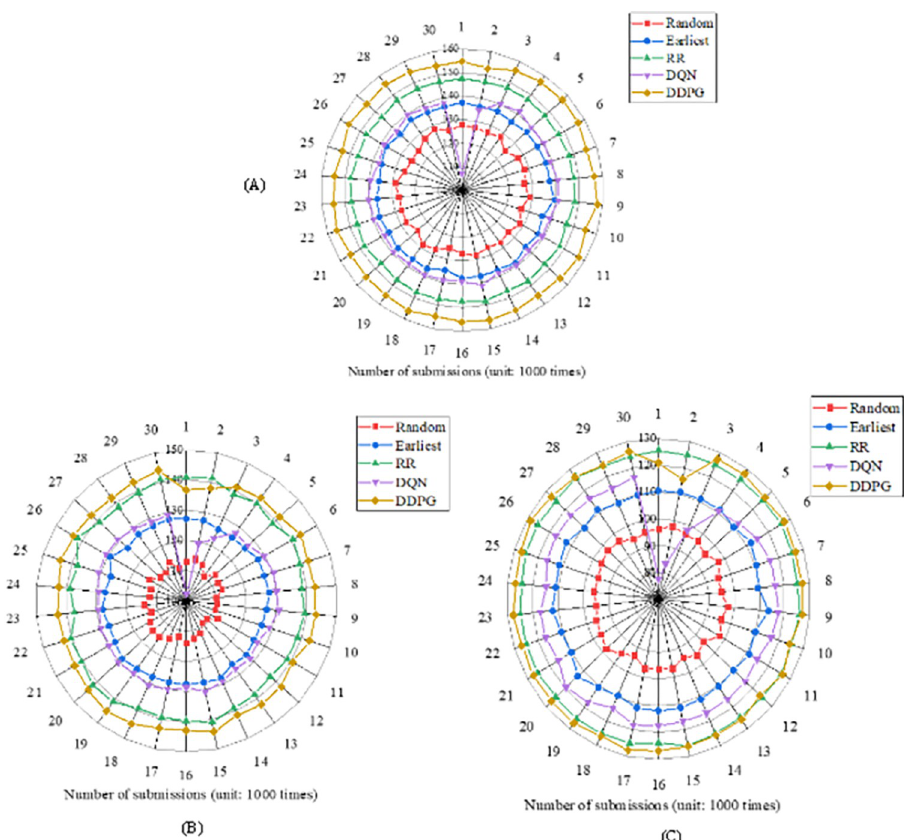
Fig 8. Task scheduling response time of different algorithms in the cloud data center in different scenarios ((A) is Scenario 1; (B) is Scenario 2; (C) is Scenario 3).